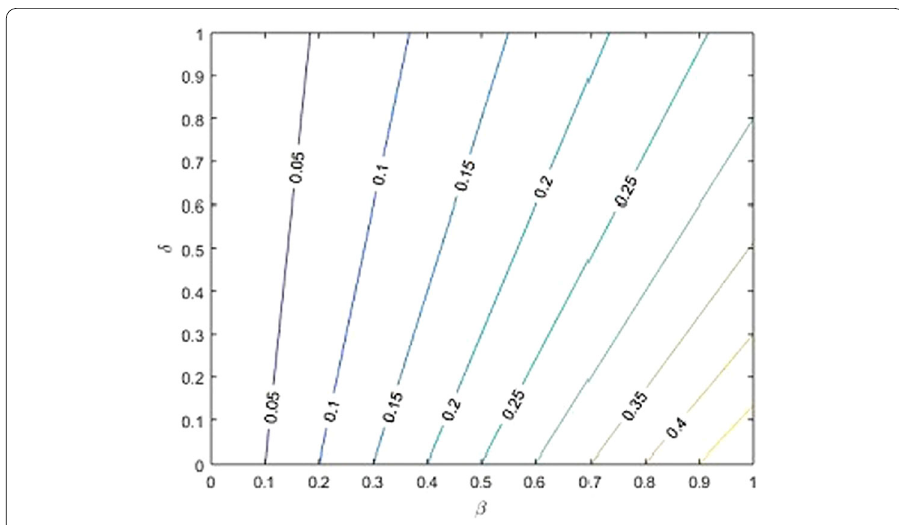
Figure 3 Contour plot of the reproductive number as functions of β and δ